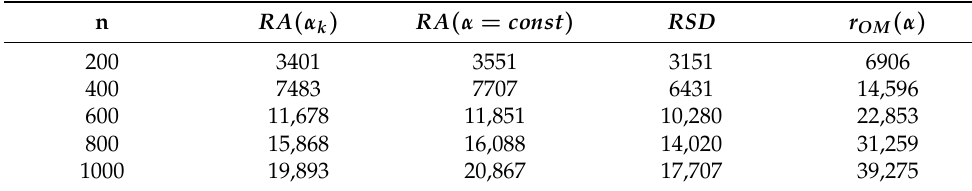
Table 6. Function f 5 ( x ) minimization